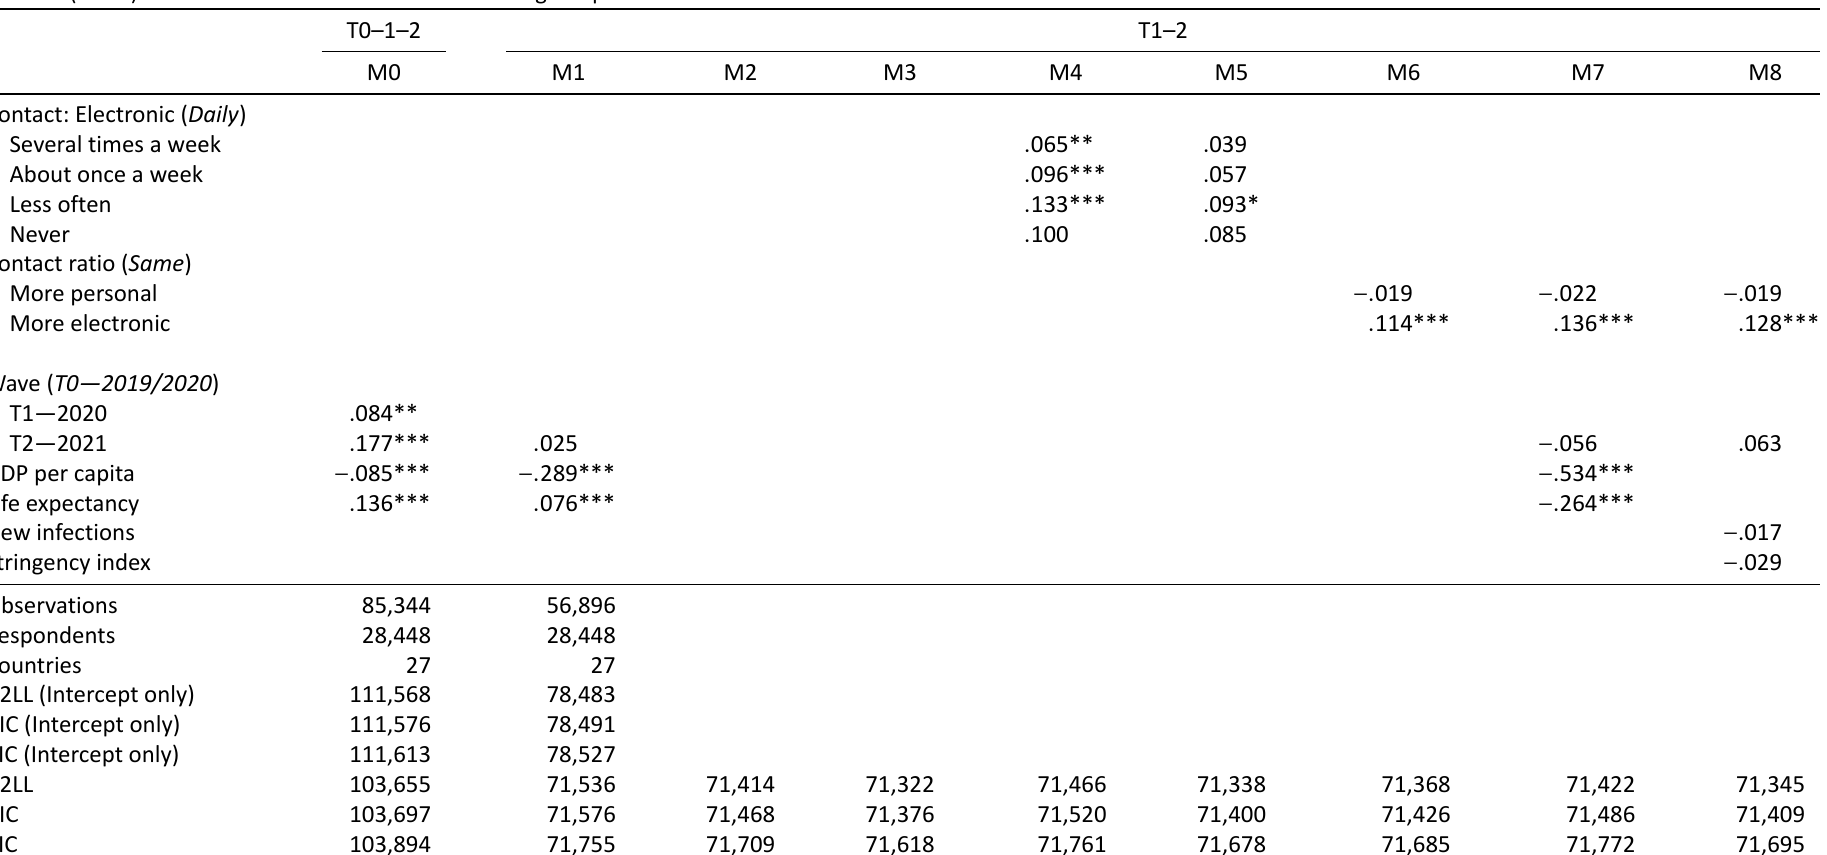
Table 1. (Cont.) Patterns of loneliness before and during the